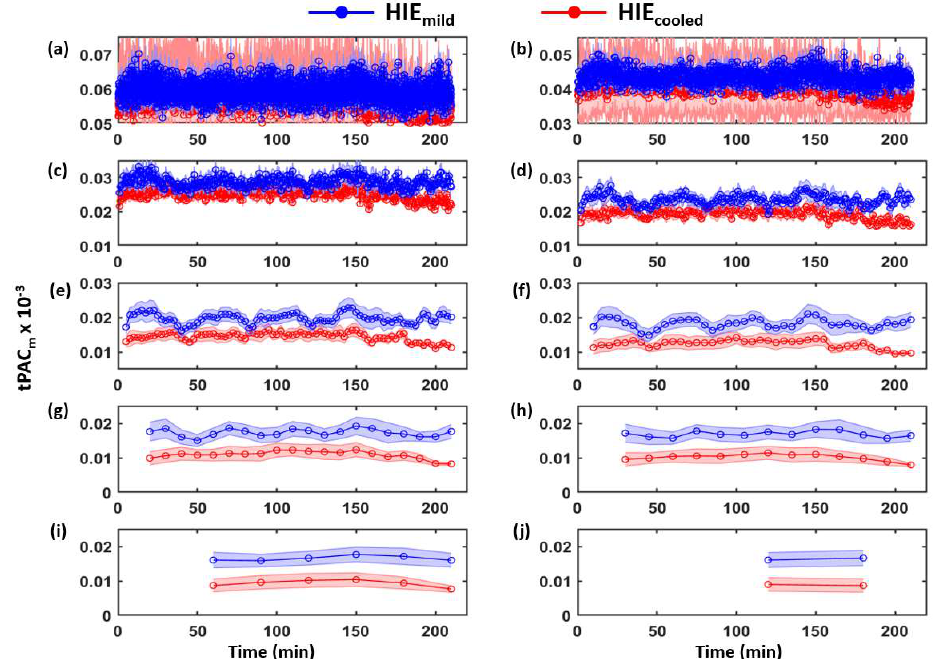
Figure A6. tPAC m indexes at O1 from HIE mild (blue) and HIE cooled (red) under ( a ) 10 s; ( b ) 20 s; ( c ) 1 min; ( d ) 2 min; ( e ) 5 min; ( f ) 10 min; ( g ) 20 min; ( h ) 30 min; ( i ) 60 min; ( j ) 120 min window sizes. Each point denotes the cross-neonate average of tPAC m for the group at different time in the 6 HOL. The shaded error bar indicates the standard error of the mean. t = 0 indicates the start of EEG recording.